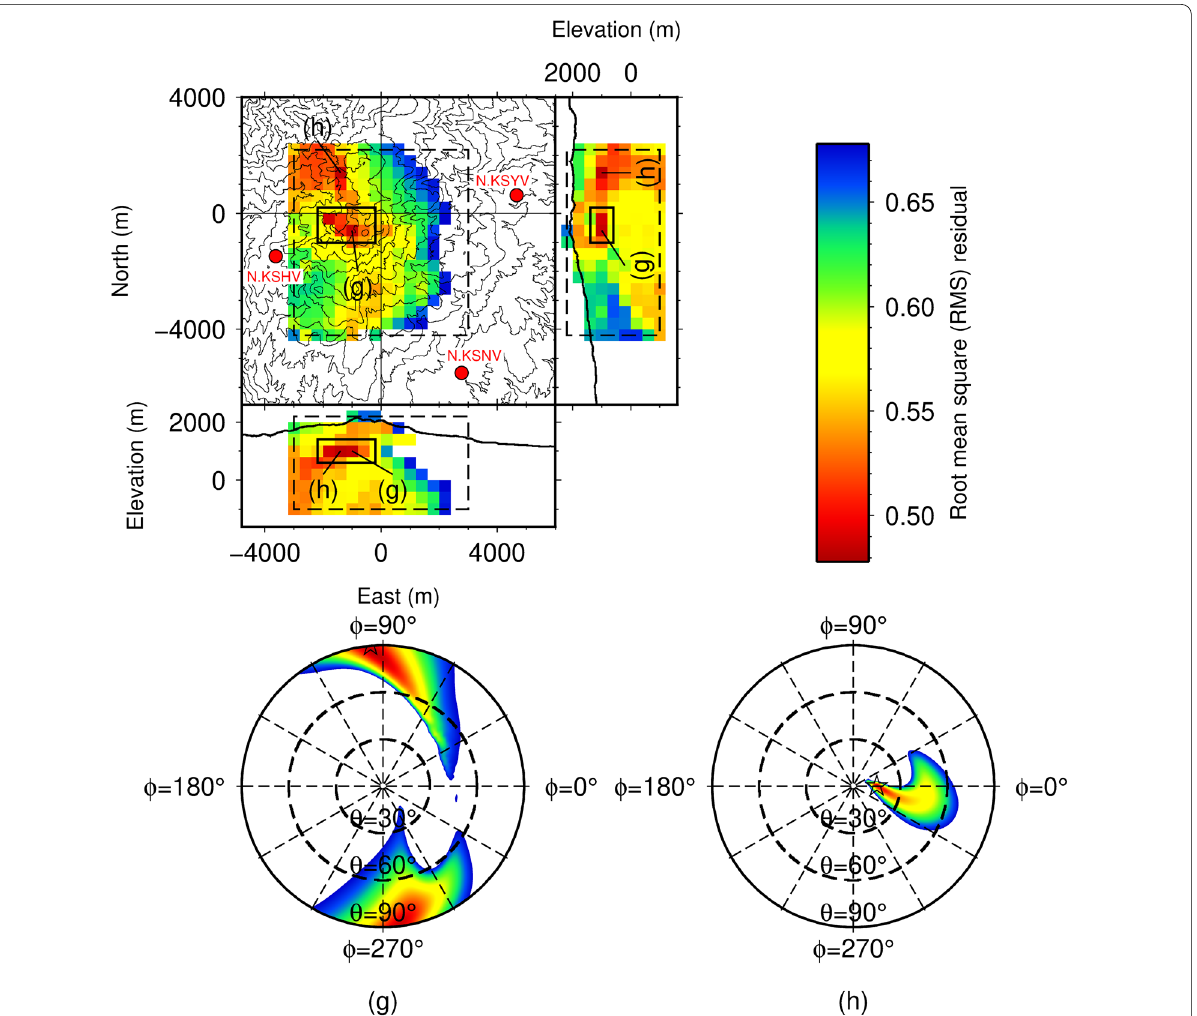
Fig. 7 Spatial distribution and crack orientation dependence of the RMS residuals between the observed and synthetic waveforms obtained by waveform inversion using the three-component broadband seismograms and the two-component tiltmeter records at the three stations (15 components). The locations of candidates ( g ) and ( h ) are indicated by straight lines on the plane map. See Fig. 5 for details concerning the plotting